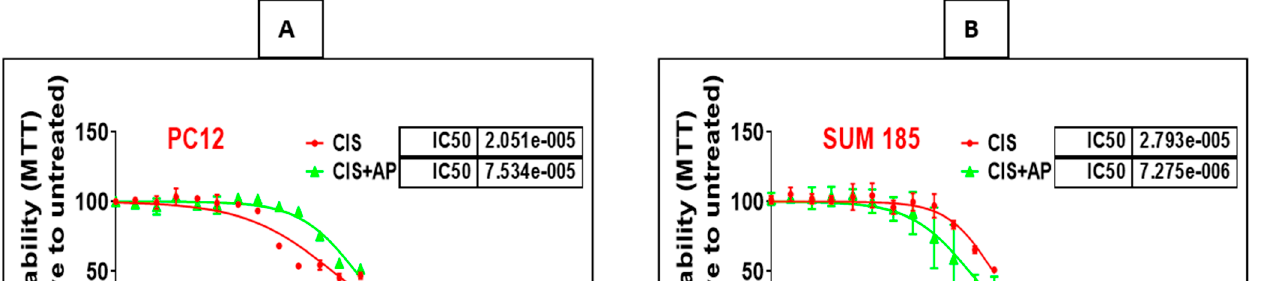
Figure 2. NK1R Antagonism protects rat neuronal PC12 cells while causing enhancement of cisplatin-induced loss of via- bility in TNBC cells. Loss of viability induced by cisplatin in the presence and absence of aprepitant in rat neuronal PC12 cells, Sum 185 and Sum 159 cells ( A – C ) and IC 50 levels of cisplatin in the presence and absence of aprepitant in PC12 and TNBC cells ( D ) (* , † , ‡ , p ≤ 0.05, Student’s t -test, n = 2–3).